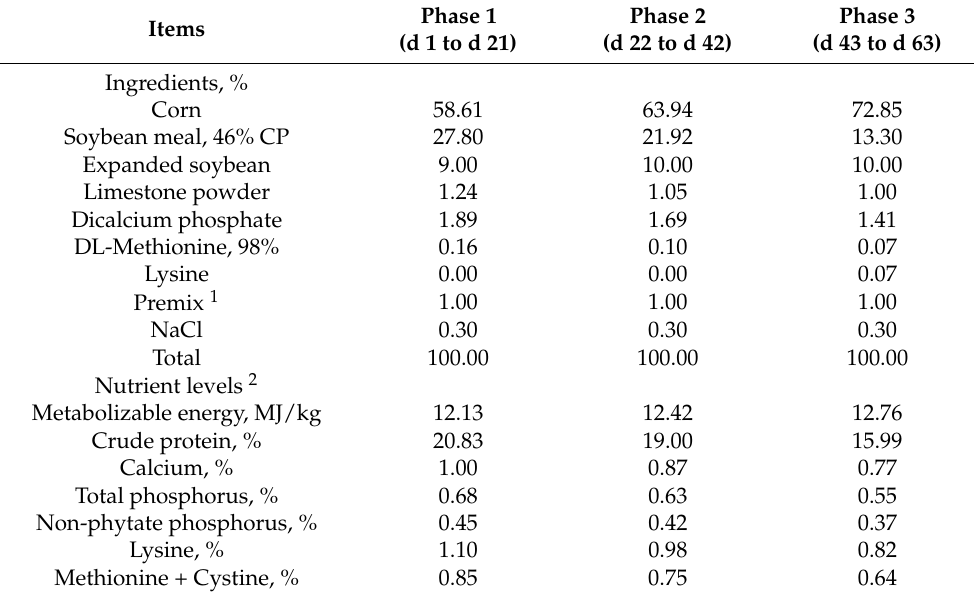
Table 1. Composition and nutrient levels of basal diets (air-dry